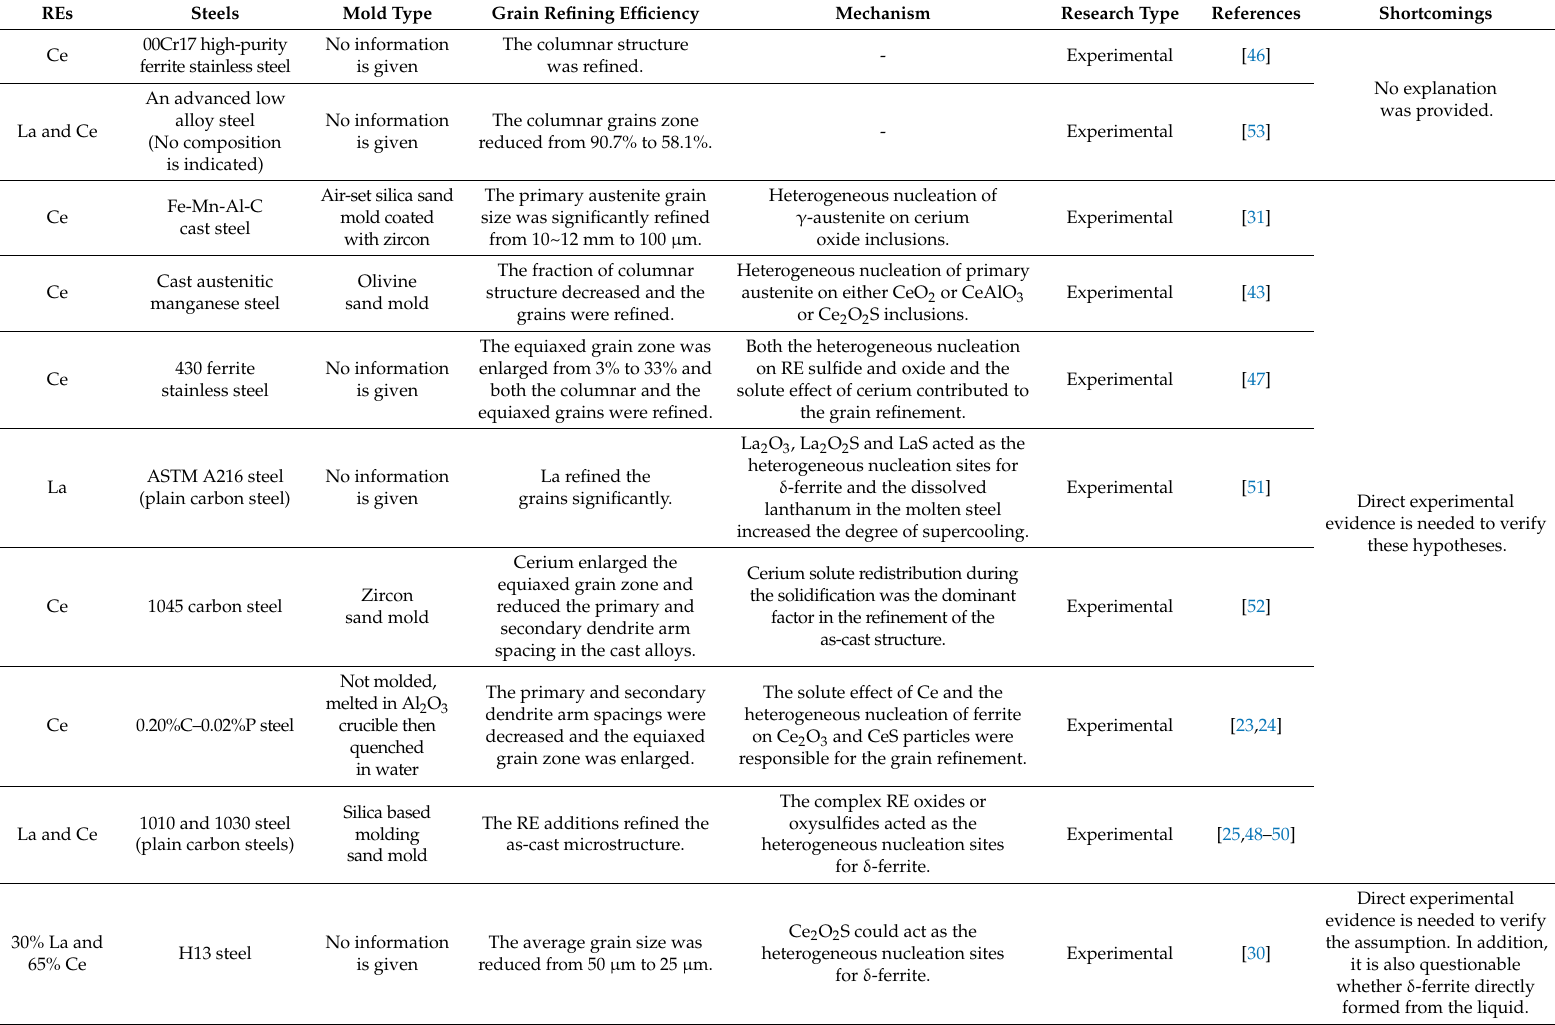
Table 1. Published works on grain refinement of as-cast steels through addition of lanthanum or/and